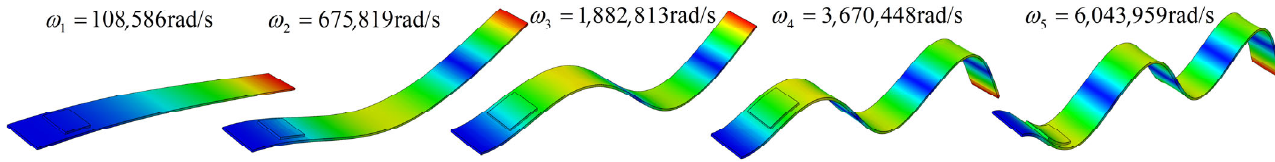
Figure 8. The first five order bending angular natural frequencies and relative mode shapes. Putting these bending natural frequencies into Equation (11), the Young’s modulus and density of the adsorbate were calculated from each frequency pair, as shown in Table 5. Table 5. The Young’s modulus and density calculated from different natural frequency pairs. Parameters